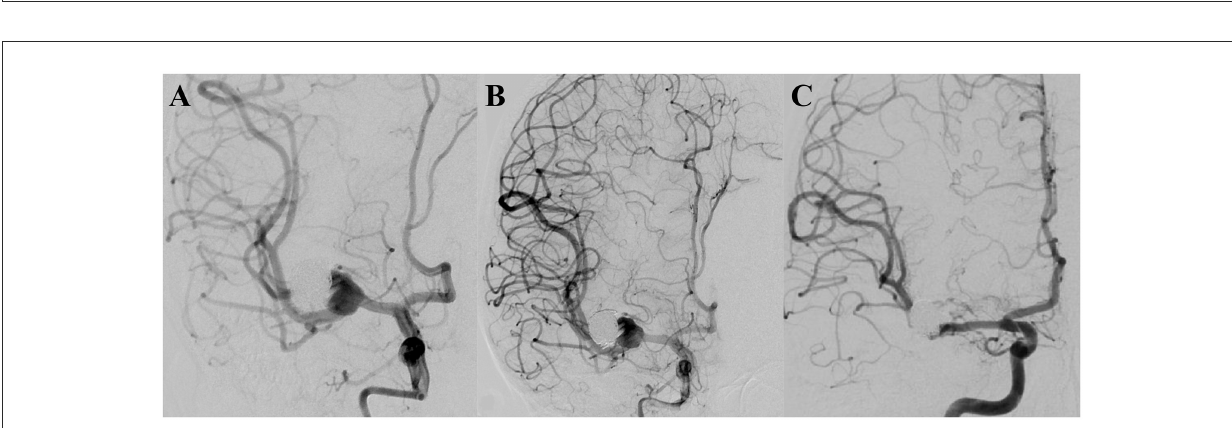
FIGURE2 (A) Pre-operative digital subtraction angiography showing the aneurysm to be recurrent. (B) A successfully implanted single pipeline embolization device, and digital subtraction angiography analysis, revealing the retention of contrast media in the aneurysm. (C) Follow-up digital subtraction angiography, 3 months after the operation, indicating the aneurysm to be completely